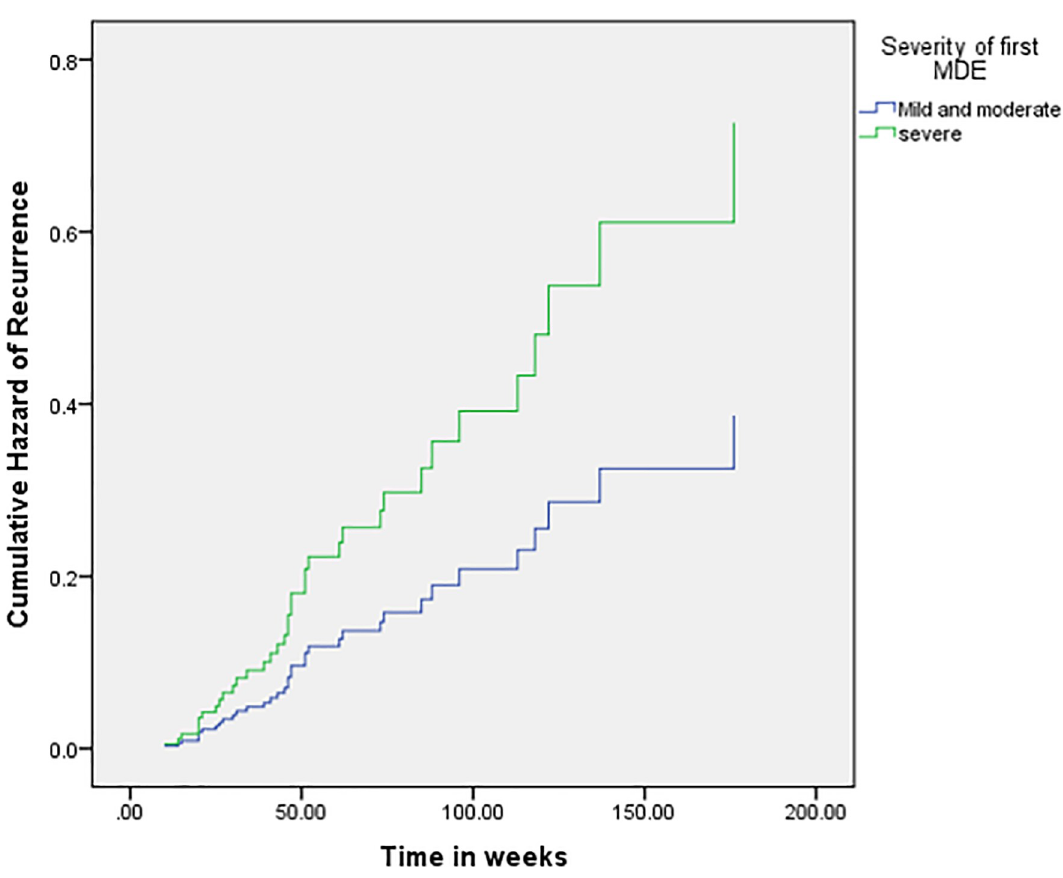
Fig 1. Hazard function for recurrence of MDD by severity at first